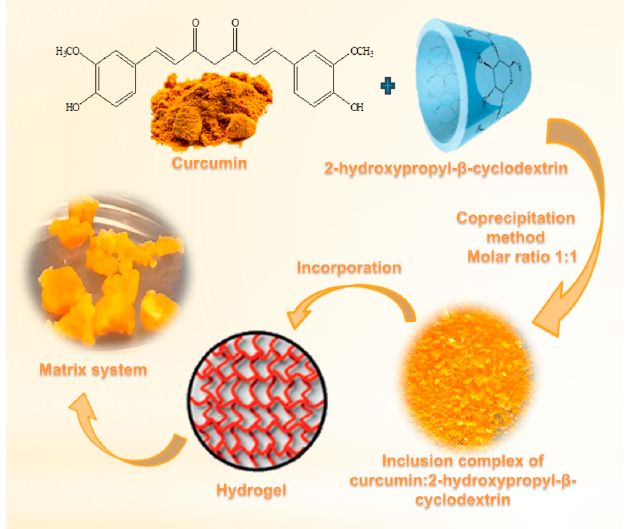
Figure 4. The schematic view of obtaining the formulation of curcumin:2 ‐ hydroxypropyl ‐β‐ cyclodextrin complex with p(NiPMAm/NiPAm) hydrogel.